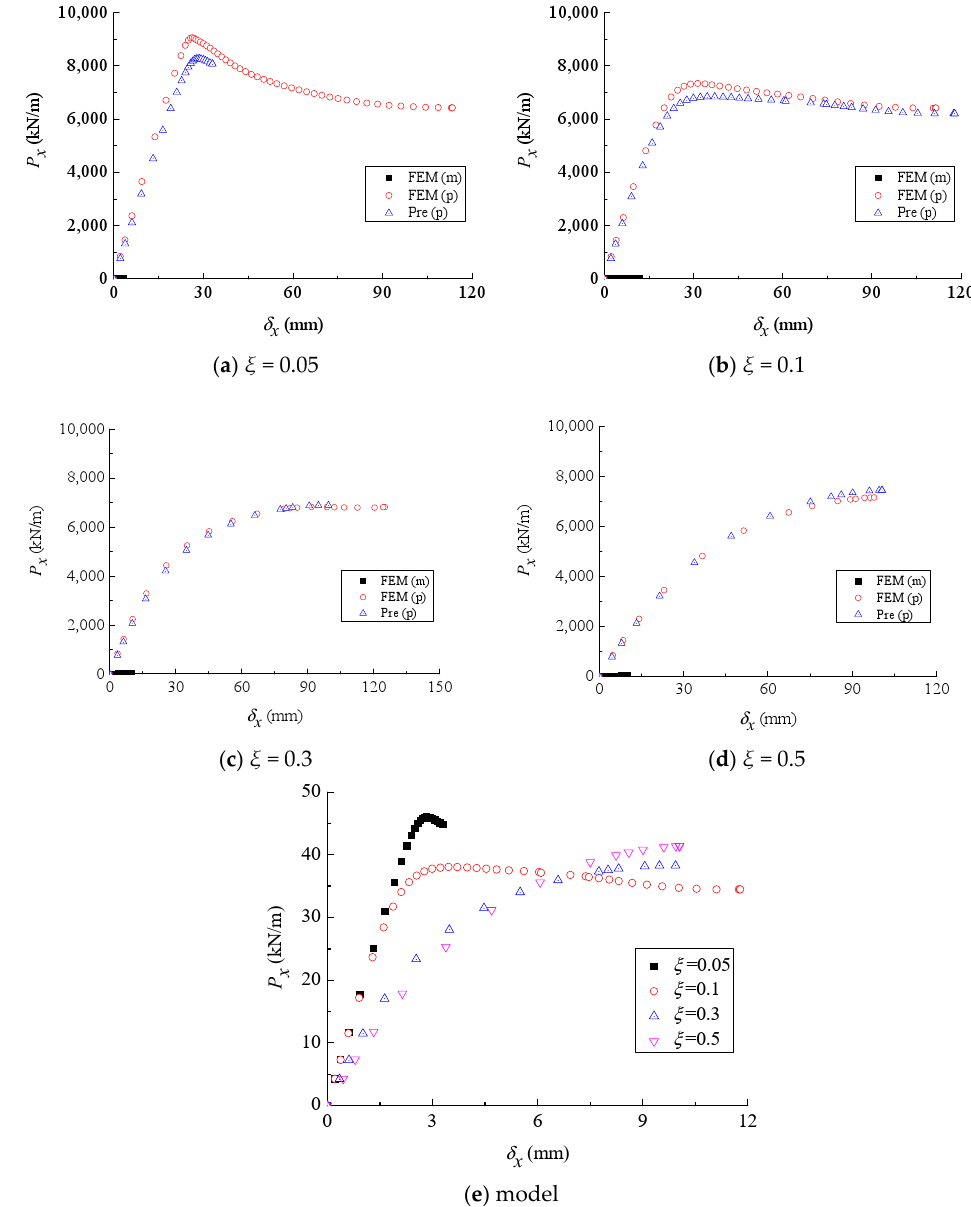
Figure 8. Comparison of the predicted and original load vs. end-shortening curves of the stiffened cylinders with L / R = 2.51 and the SS3 boundary condition when the model material is PVC. When the material of the model is AL, Figure 10 shows the results of partial similarity and the equilibrium paths of the models for axial compression post-buckling of T-type stiff- ened cylinders with the SS3 boundary condition and four different geometric imperfections ( ξ = 0.05, 0.1, 0.3, and 0.5). As shown in Figure 10a–d, the equilibrium paths of the models can predict the results of its prototype using the scaling law Equation (25) and the deforma- tion scaling factor. At the limit points of the equilibrium paths, the buckling mode shapes of the models are both (1,3), and only the case of ξ = 0.05 is given, as shown in Figure